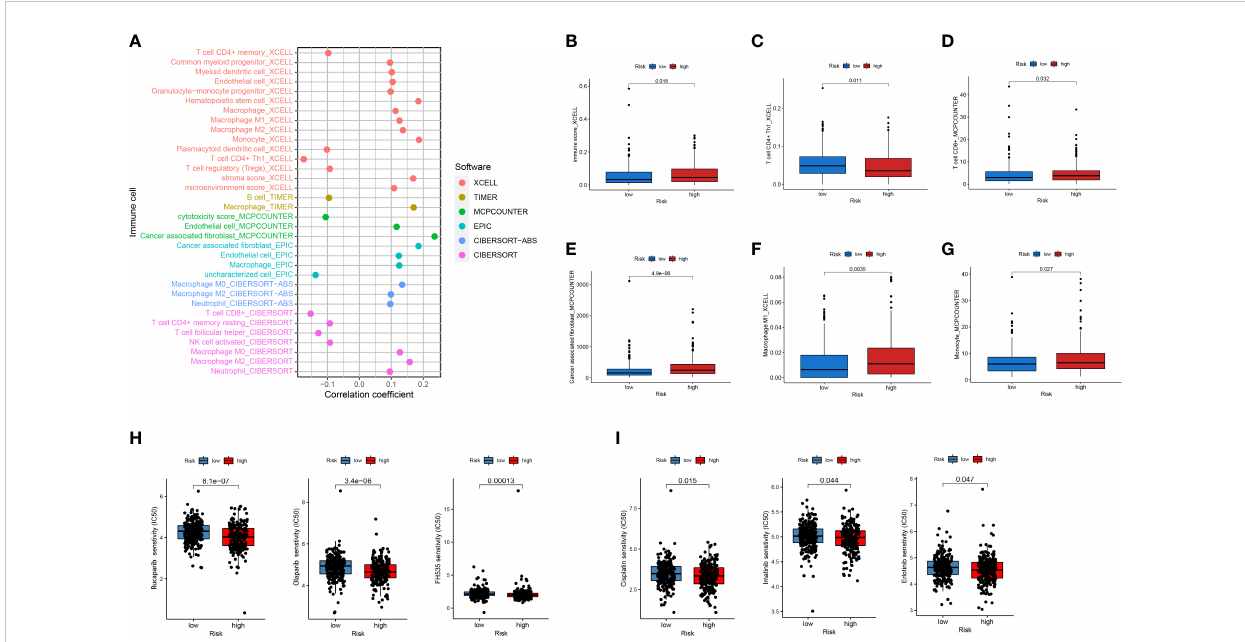
FIGURE 5 Analysis of immune cell in fi ltration and drug sensitivity between high- and low-risk subgroups. (A) Six commonly used methods such as XCELL, TIMER, and EPIC to assess the relevance of immune-related cells to risk scores. (B – G) Differences in CD4 + T cells, CD8 + T cells, macrophages, and others in high- and low-risk subgroups. (H, I) Differences in IC 50 between high- and low-risk subgroups for PARP inhibitors and commonly used fi rst-line CRC drugs.